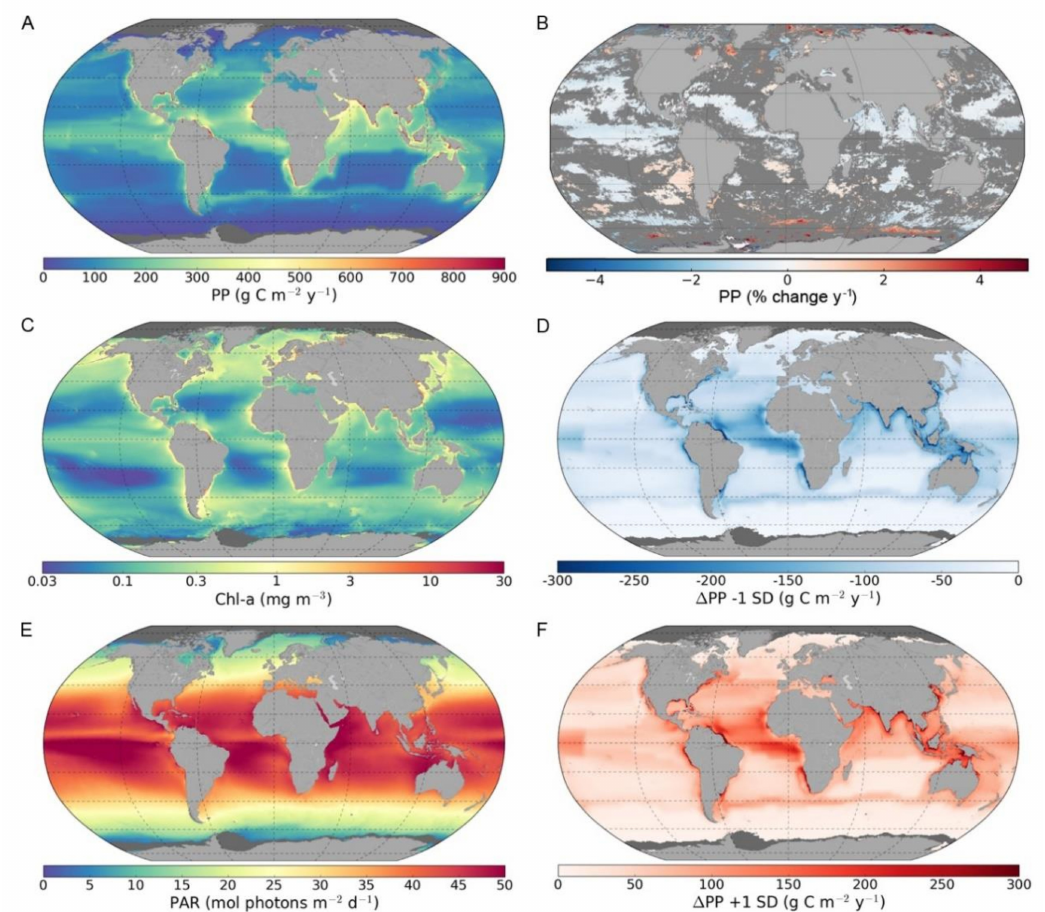
Figure 3. Maps of global annual primary production (PP) and associated parameters for the period of 1998–2018: ( A ) global annual primary production based on mean photosynthesis versus irradiance (P-I) parameters; ( B ) linear trends in global annual primary production between 1998 and 2018 given as percentage change per year (dark grey colour represents non-significant trends); ( C ) remote-sensing-derived mean surface chlorophyll- a (Chl-a); ( D ) difference in primary production between mean P-I parameters and –1 standard deviation (–1 SD)-based estimations; ( E ) remote-sensing-derived Photosynthetic Active Radiation (PAR, 400–700 nm); and ( F ) difference in primary production between mean P-I parameters and +1 standard deviation (+1 SD)-based estimations.